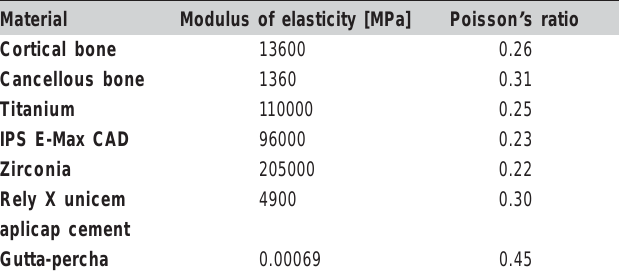
Table 1: Material’s properties used in the FE models 13